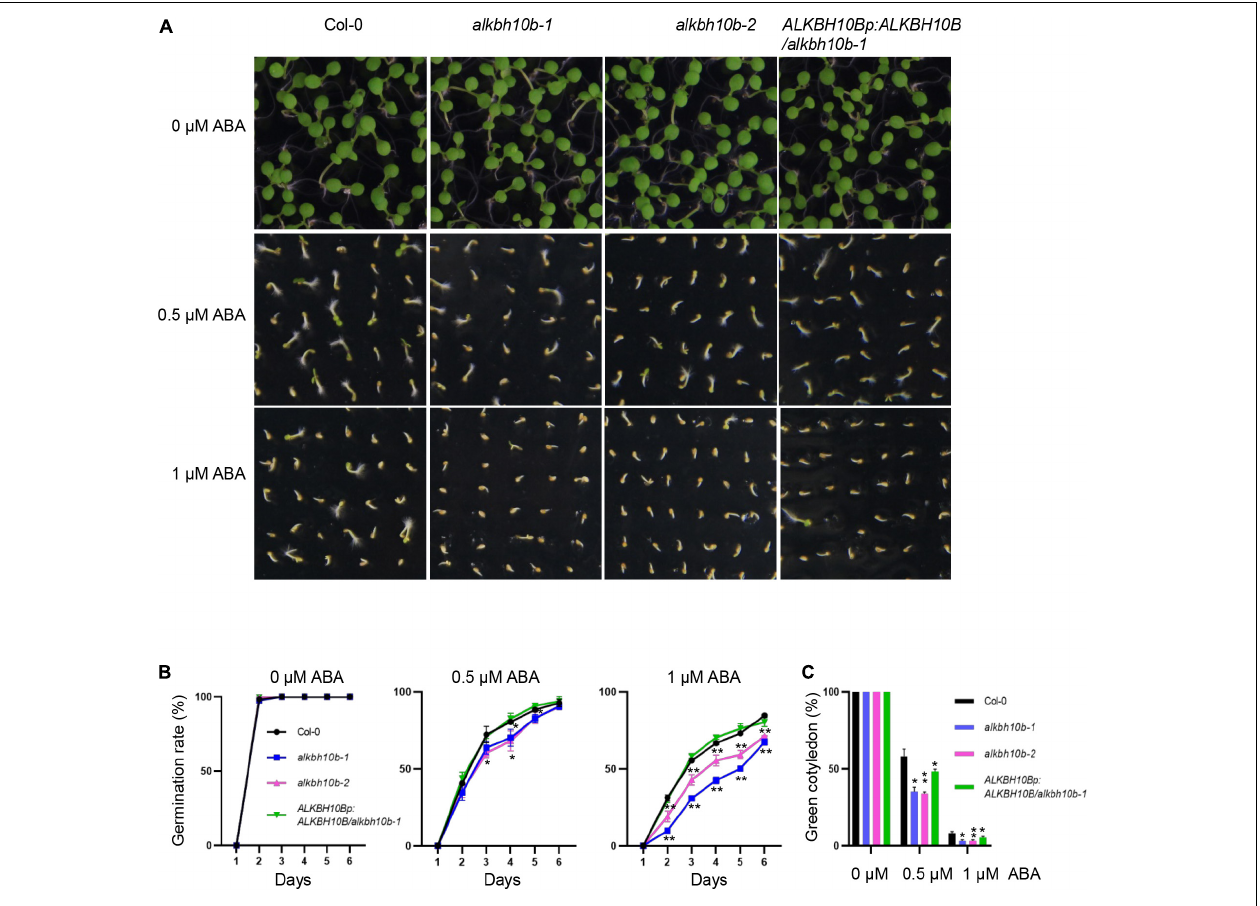
FIGURE 2 | ALKBH10B modulates ABA sensitivity during seed germination. The germination rates of indicated genotypes were recorded from 1–6 days after stratification in the presence of various ABA contents (0, 0.5, or 1.0 µ M). Cotyledon-greening percentages of the 10th day were recorded. Three independent experiments were conducted, with at least 100 seeds per genotype in each replicate. Error bars represent the standard deviation of three replicates. Asterisks indicate statistically significant differences as compared to the mock of every time-point (* P < 0.05; ** P < 0.01; Student’s t -test). (A) Photographs of seedings grown on different media at day 6 after stratification. (B) Seed germination rates of indicated genotypes grown on different medium. (C) Green cotyledon ratio at day 10 after stratification.